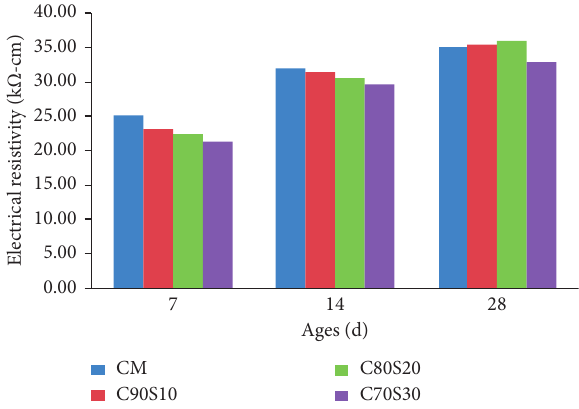
Figure 12: Electrical resistivity of concrete